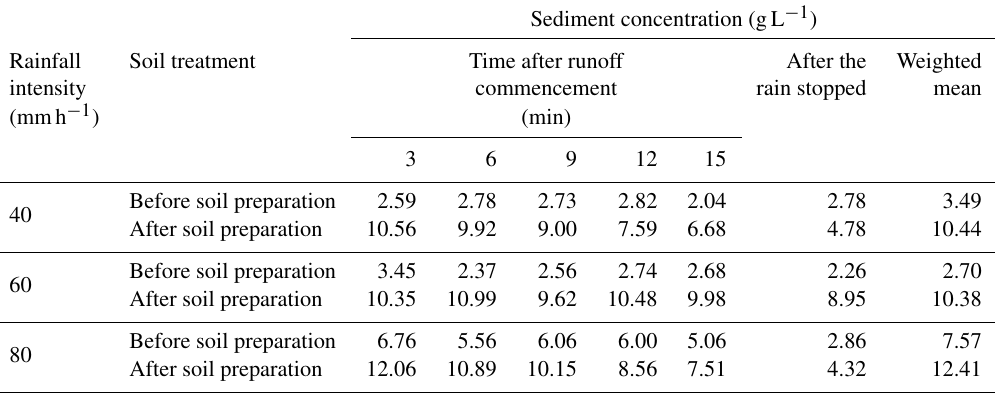
Table 2. The average sediment concentration for three replicates of both before and after soil preparation treatments in three studied rainfall intensities.